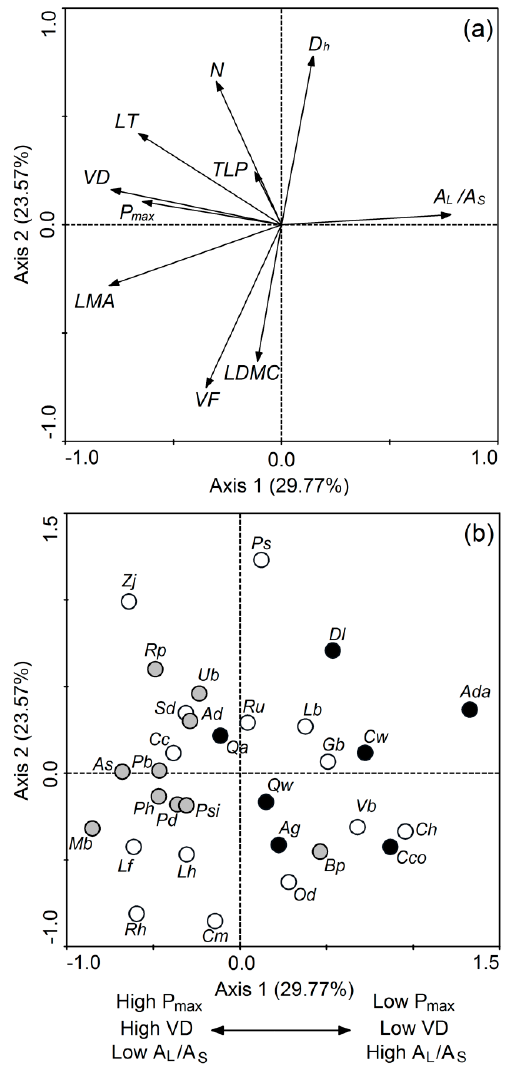
Figure 2. Principal component analysis for 10 traits ( a ) and 31 woody species ( b ) for the first two axes. Open, grey and solid circles indicate species from shrub stage, pioneer tree stage and late successional stage, respectively. Trait abbreviations: LT (leaf thickness), P max (maximum net photosynthesis rate), LDMC (leaf dry matter content), LMA (leaf dry mass per area), N (leaf nitrogen concentration per mass), VD (vein density), TLP (leaf water potential at turgor loss point), A L / A S (leaf area to sapwood area ratio), VF (vessel frequency), and D h (hydraulically weighted diameter). The abbreviations for species are provided in Table 1.